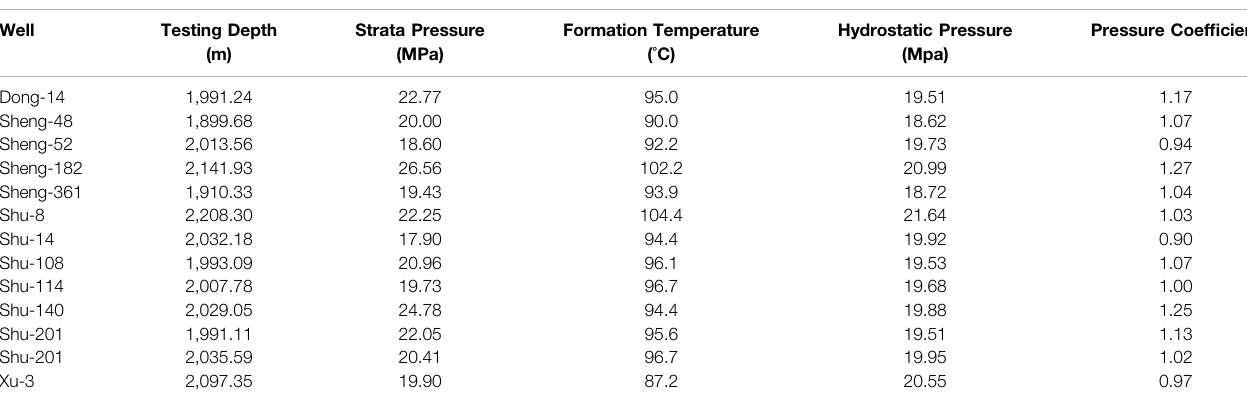
TABLE 4 | Formation test data in the Fuyu oil reservoir of the Sanzhao area.